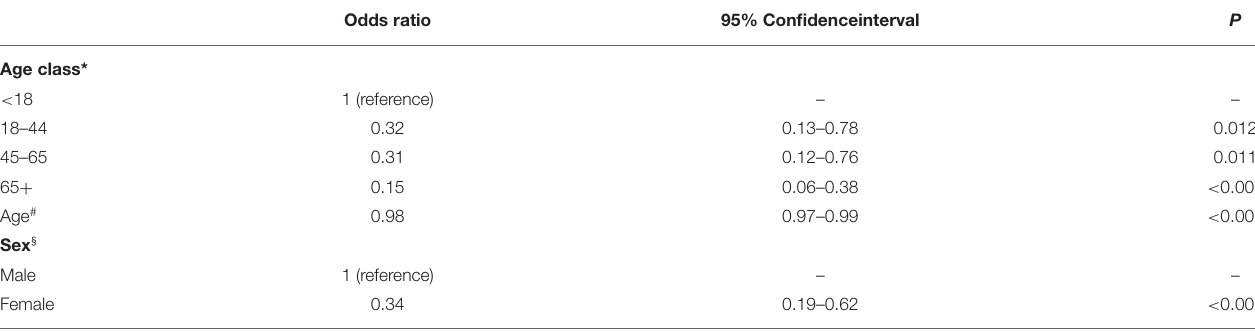
TABLE 4 | Odds ratio (OR) of having a positive TQS by age class, age (continuous variable), and